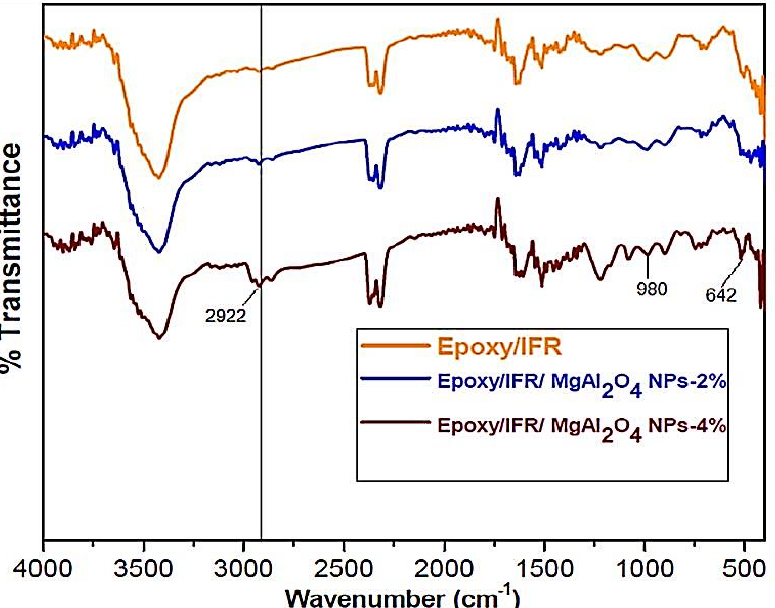
Figure 14. FTIR spectra of epoxy/IFR, epoxy/IFR/MgAl 2 O 4 NPs-2% and epoxy/IFR/MgAl 2 O 4 NPs-4%